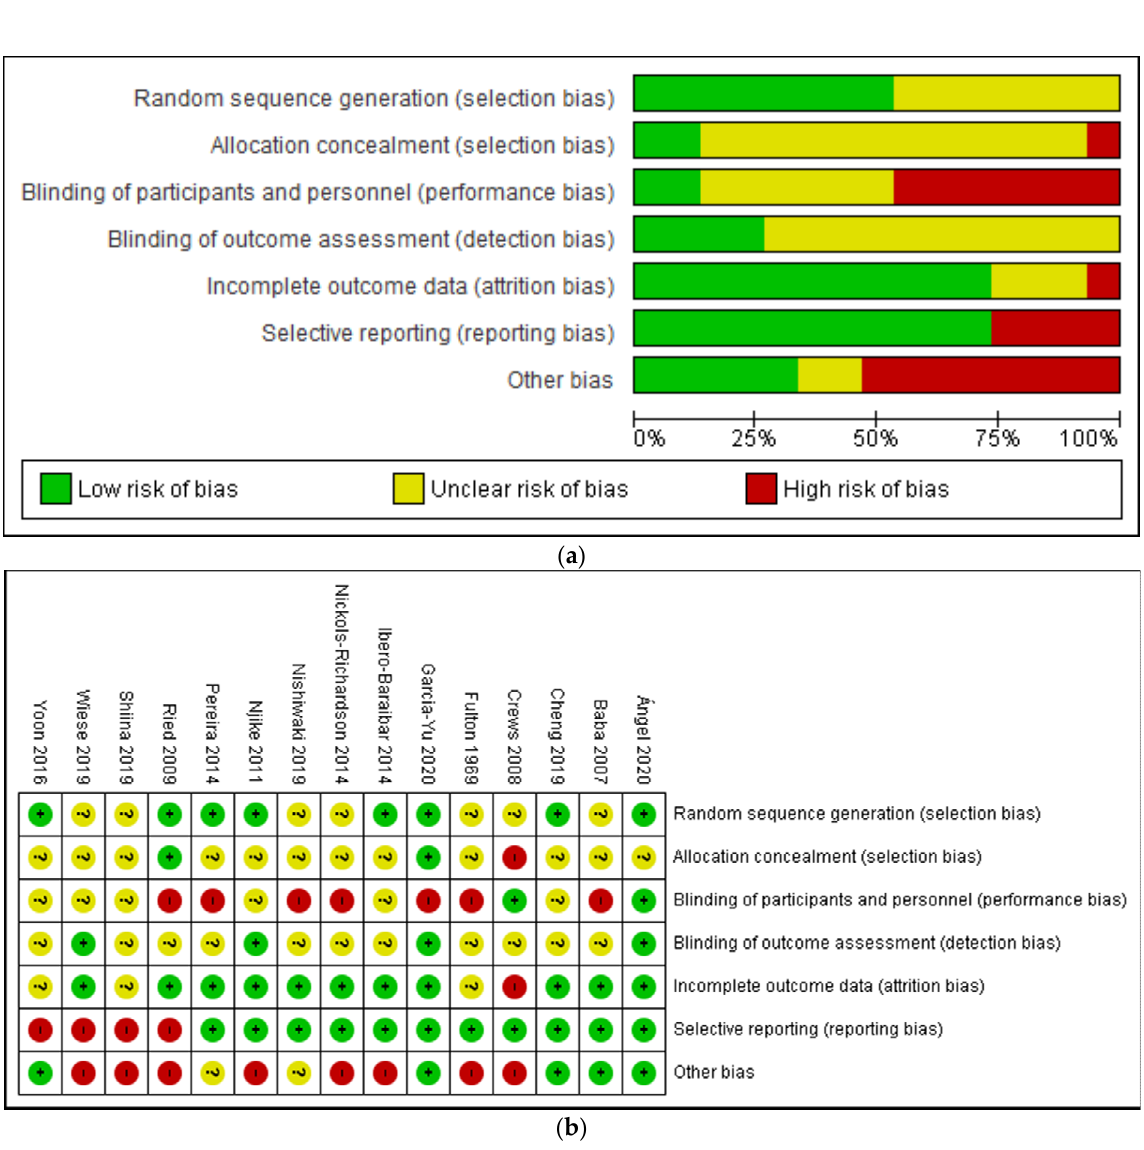
Figure 2. ( a ) Risk of bias assessment (ROB) graph and ( b ) ROB summary of included studies based on authors’ judgment.